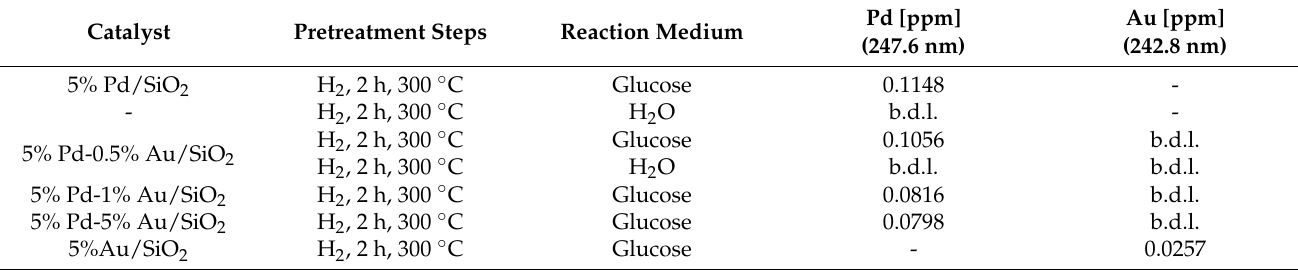
Table 3. ICP ‐ AES analysis of the reaction mixture after catalytic tests. Reaction conditions: T = 60 °C, m cat = 1 g, C 0 = 1